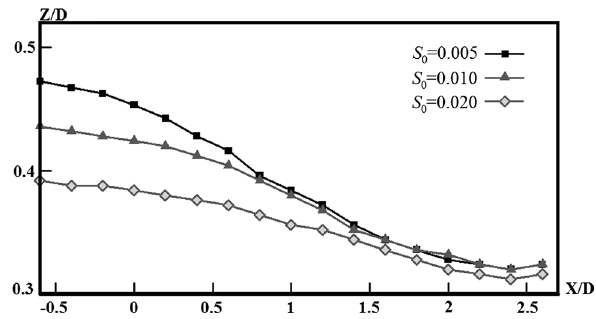
nel central axis for different slopes